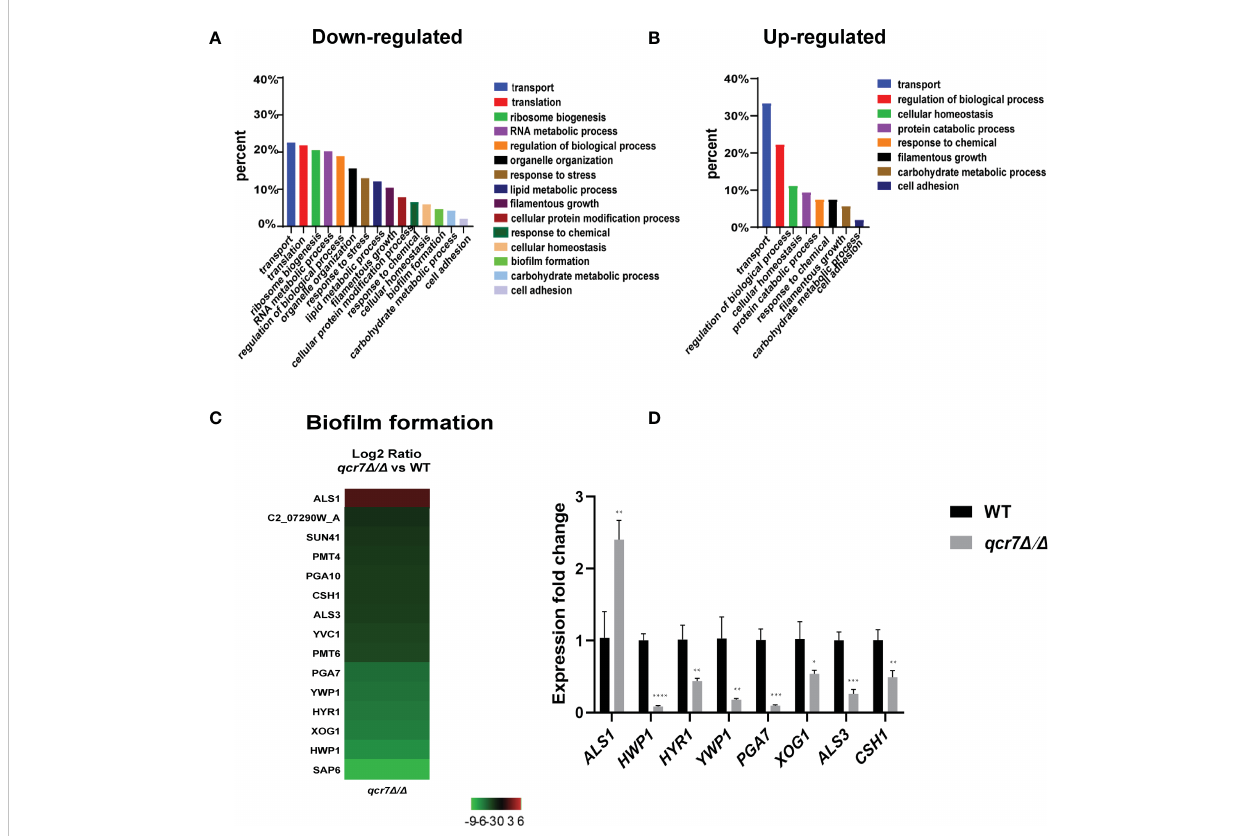
FIGURE 5 Comparative transcriptomic analysis of QCR7 mutants of C albicans . The distribution of signi fi cantly downregulated (A) or upregulated (B) genes in the GO category “ molecular process ” following qcr7 D / D , compared with the wild type. (C) A heatmap displaying the upregulated and downregulated genes that associate partly with the GO category “ bio fi lm formation ” . Fold enrichment of these genes is shown in Table S3. (D) Validation of the genome-wide transcriptional data by qPCR in the qcr7 D / D mutant strain. “ * ” represents p < 0.05, “ ** ” represents p < 0.01, “ *** ” represents p < 0.001 and “ **** ” represents p < 0.0001 for the WT vs. mutant